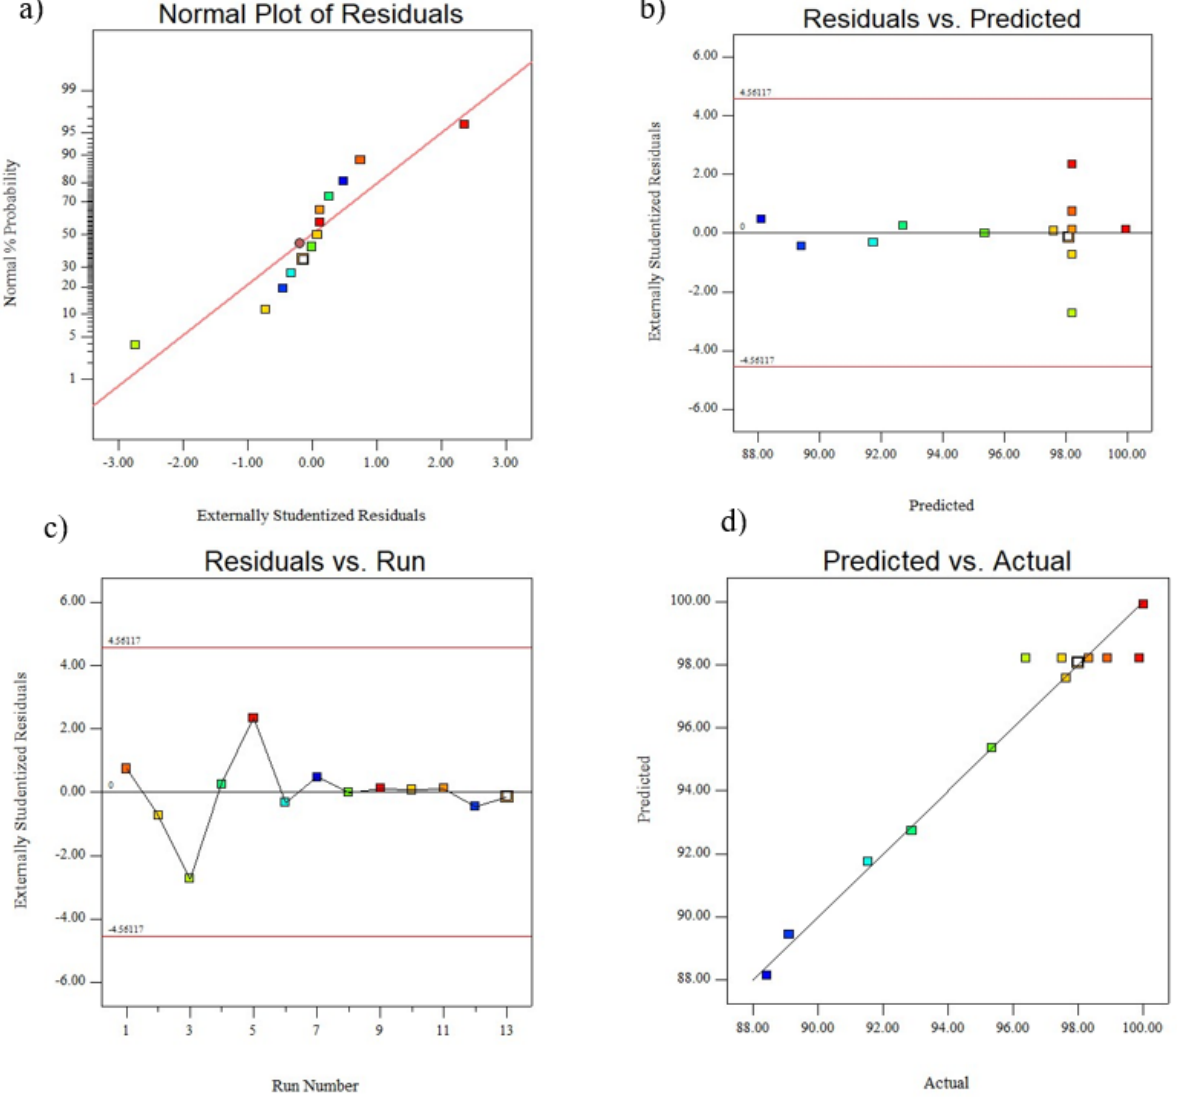
Figure 2. The normal probability plot of residuals ( a ), externally studentized residuals vs. predicted ( b ), externally studentized residuals vs. the run number ( c ), and predicted vs. actual plots ( d ) for Pb removal.